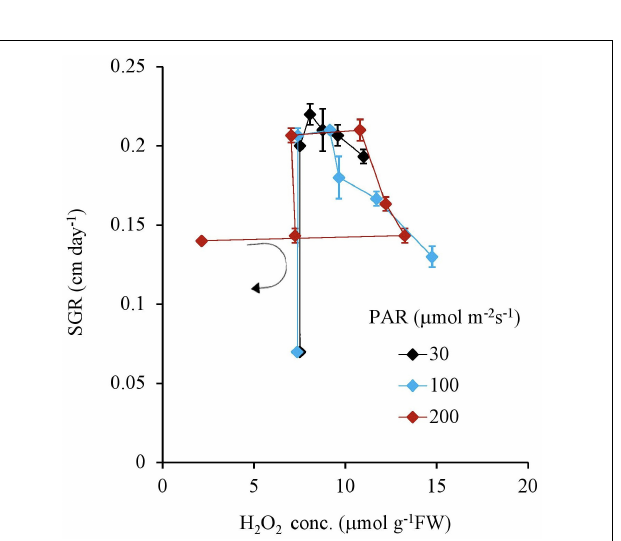
FIGURE 6 | The relation between H 2 O 2 and IAA concentrations of plant tissues after 7 days experiment as a function of Fe concentration in water and PAR intensities. The round arrow indicates the variational trend with increasing Fe concentration. Vertical bars indicate the standard deviation.